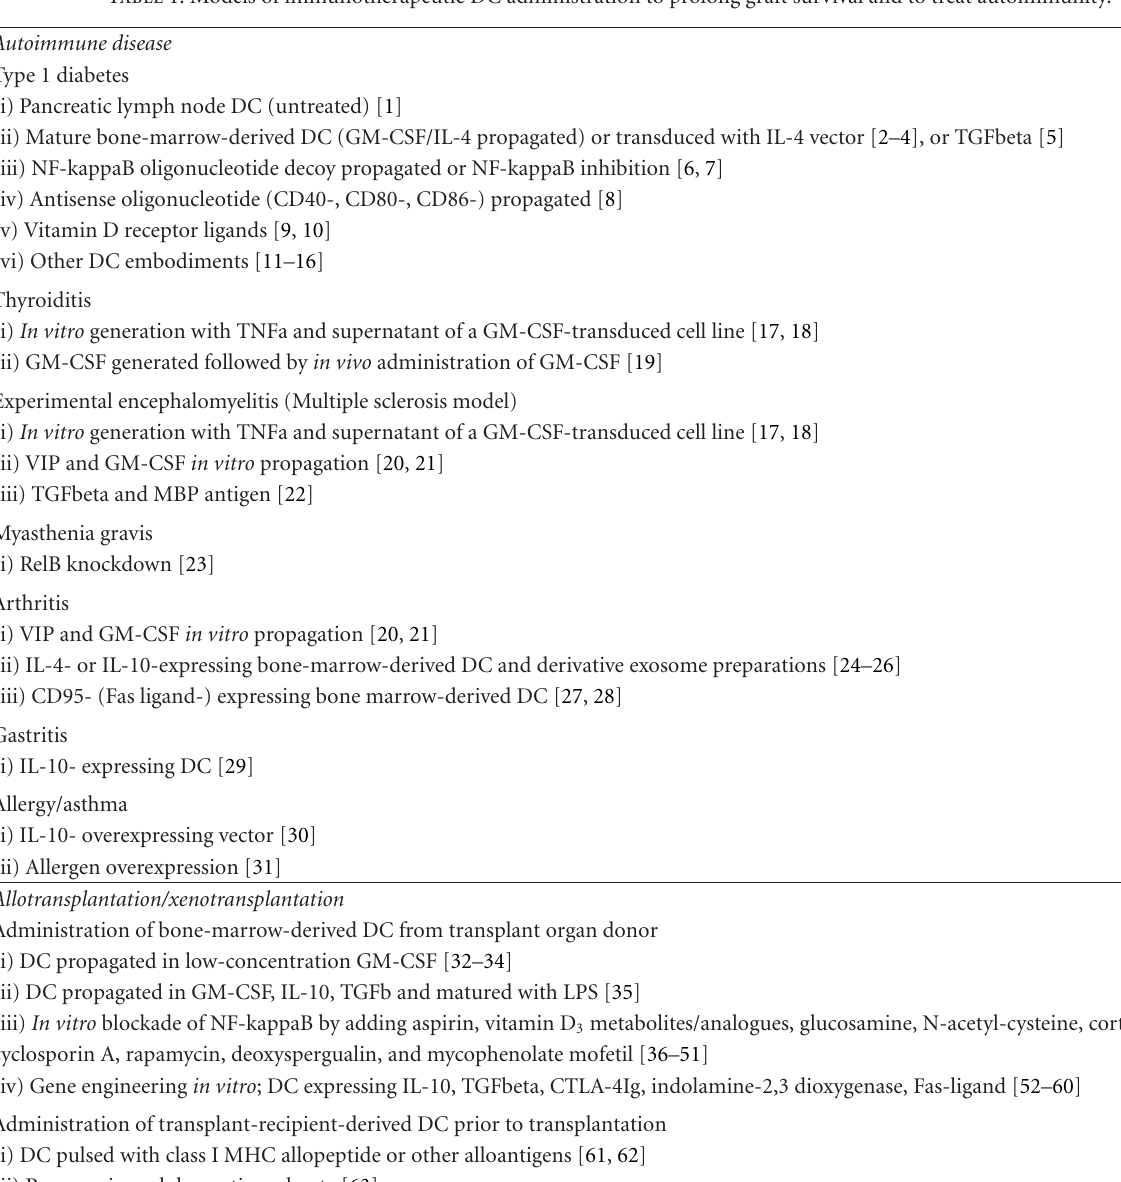
Table 1: Models of immunotherapeutic DC administration to prolong graft survival and to treat